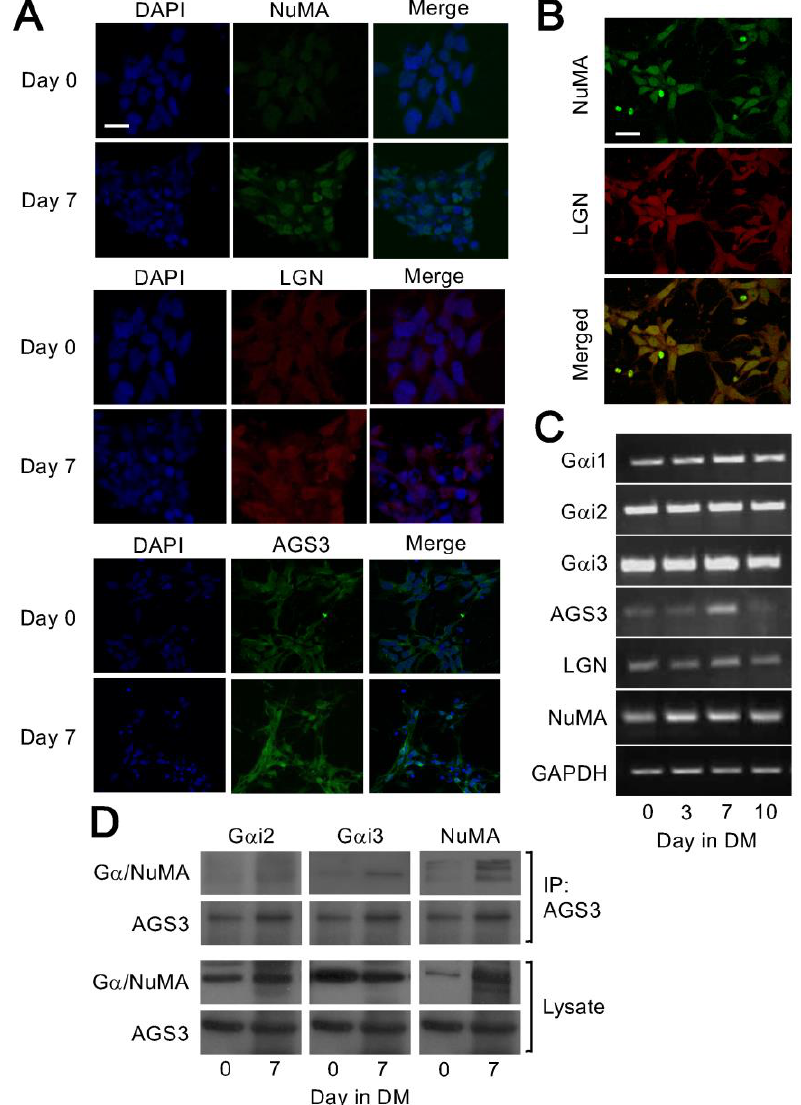
Figure 3. Co-localization and complex formation by upregulated spindle orientation proteins during di ff erentiation of ENStem-A cells. ( A ) ENStem-A cells were fixed by 4% paraformaldehyde at Day 0 and Day 7 of di ff erentiation. Cell nuclei were stained with DAPI and the presence of NuMA, LGN, and AGS3 detected by fluorescence staining using specific antisera. Images were obtained with a Zeiss LSM700 confocal microscope. Scale bar indicates 10 µ m. ( B ) Images of LGN and NuMA at Day 7 were merged (bottom panel) to illustrate their co-localization. Scale bar indicates 10 µ m. ( C ) ENStem-A cells were induced to undergo di ff erentiation and total RNA was extracted using RNeasy Mini kit (Qiagen) at Day 0, Day 3, Day 7 and Day 10. Each RNA sample was then subjected to reverse transcription to generate cDNA followed by PCR amplification with primers corresponding to G α i1 , G α i2 , G α i3, AGS3, LGN, NuMA and GAPDH. ( D ) ENStem-A cells were induced to undergo di ff erentiation and cell lysates were collected at Day 0 and Day 7 of di ff erentiation. Samples were incubated with anti-AGS3 antisera and then immunoprecipitated using protein G agarose. Presence of G α i2 , G α i3 and NuMA in the immunoprecipitates (IP) and cell lysates were detected by Western blotting with specific